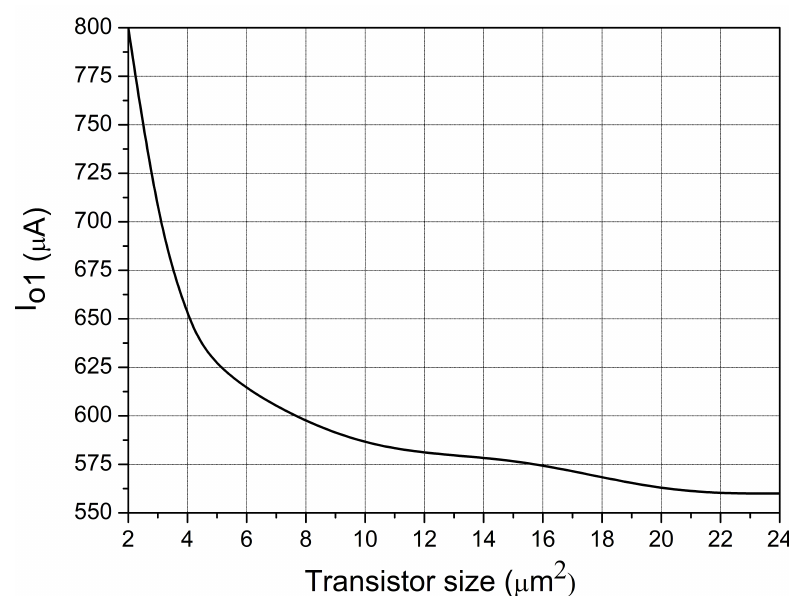
Figure 3. Schematic of the RF-VGA after simplification.